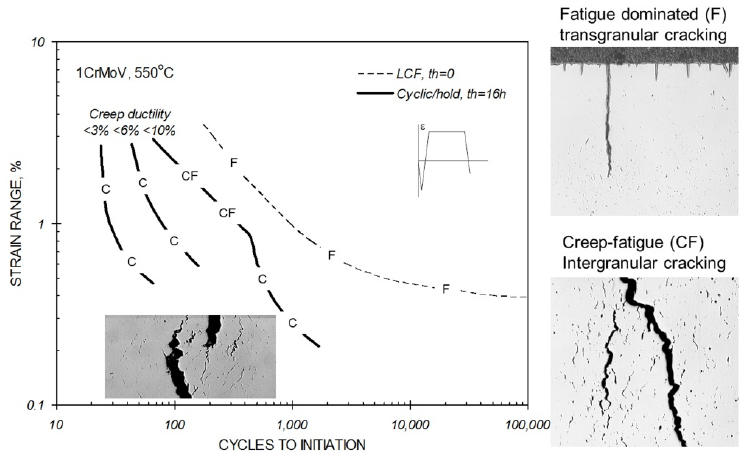
Figure 3. Influence of creep ductility on the cyclic/hold creep ‐ fatigue endurance of 1CrMoV steel at 550 °C.